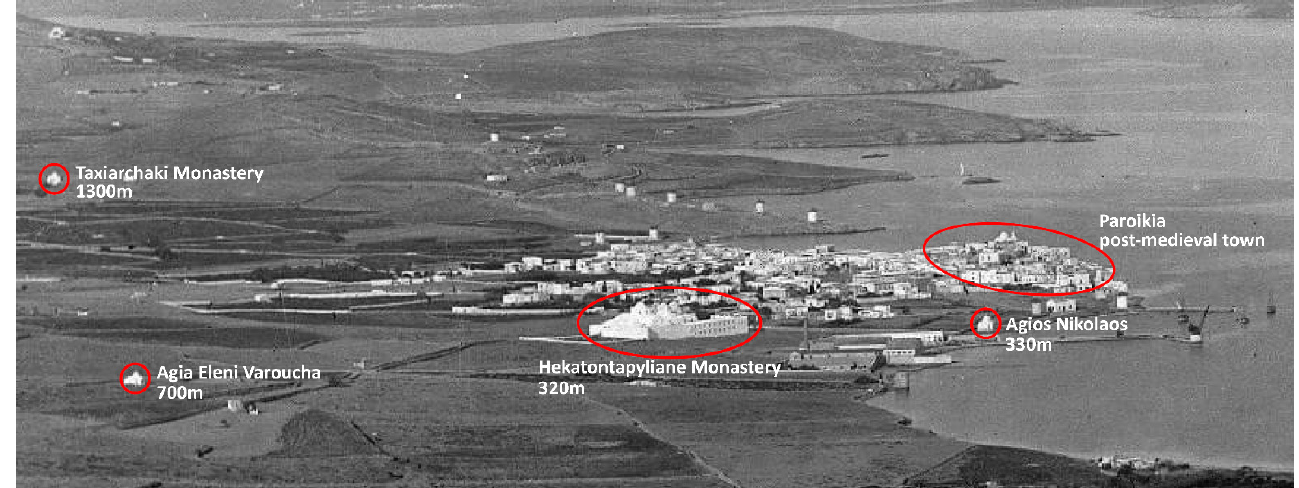
Figure 10. The town of Paroikia and its immediate territory in the 1950s. Red circles indicate the extent of the town in post-medieval times and the location of monasteries and churches visible on the photograph, together with their distance from the market ( Agora ) of Paroikia in the Ottoman era (© The History of Paros private collection, Paros, adapted by the author).